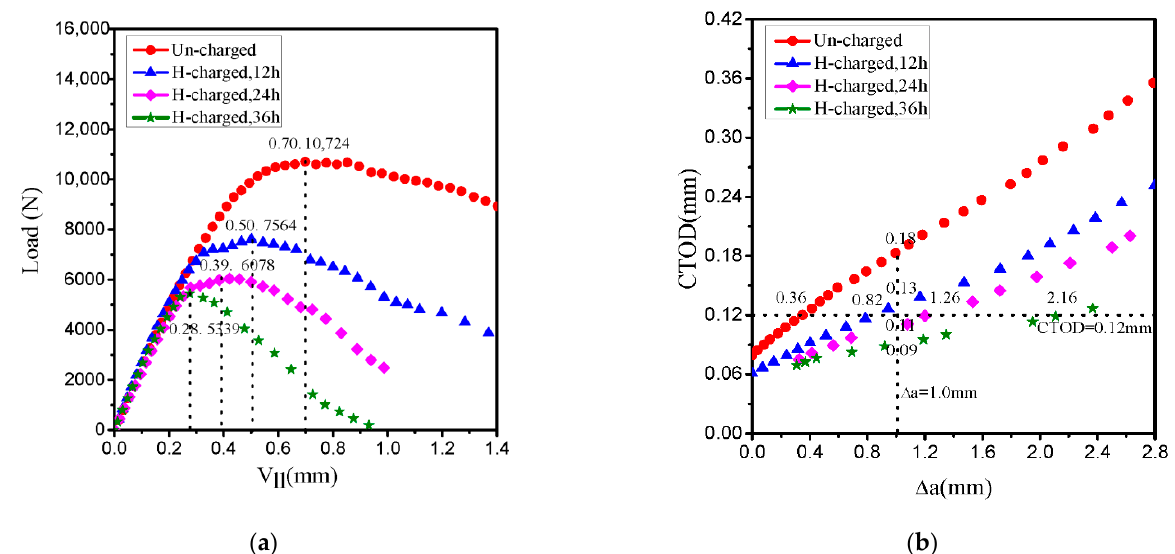
Figure 3. ( a ) Load-line displacement and ( b ) crack growth resistance (CTOD-R) curves for uncharged and hydrogen-charged specimen.